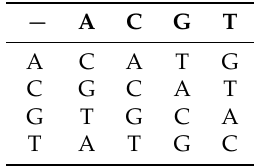
Table 3. Subtraction operation of DNA code.